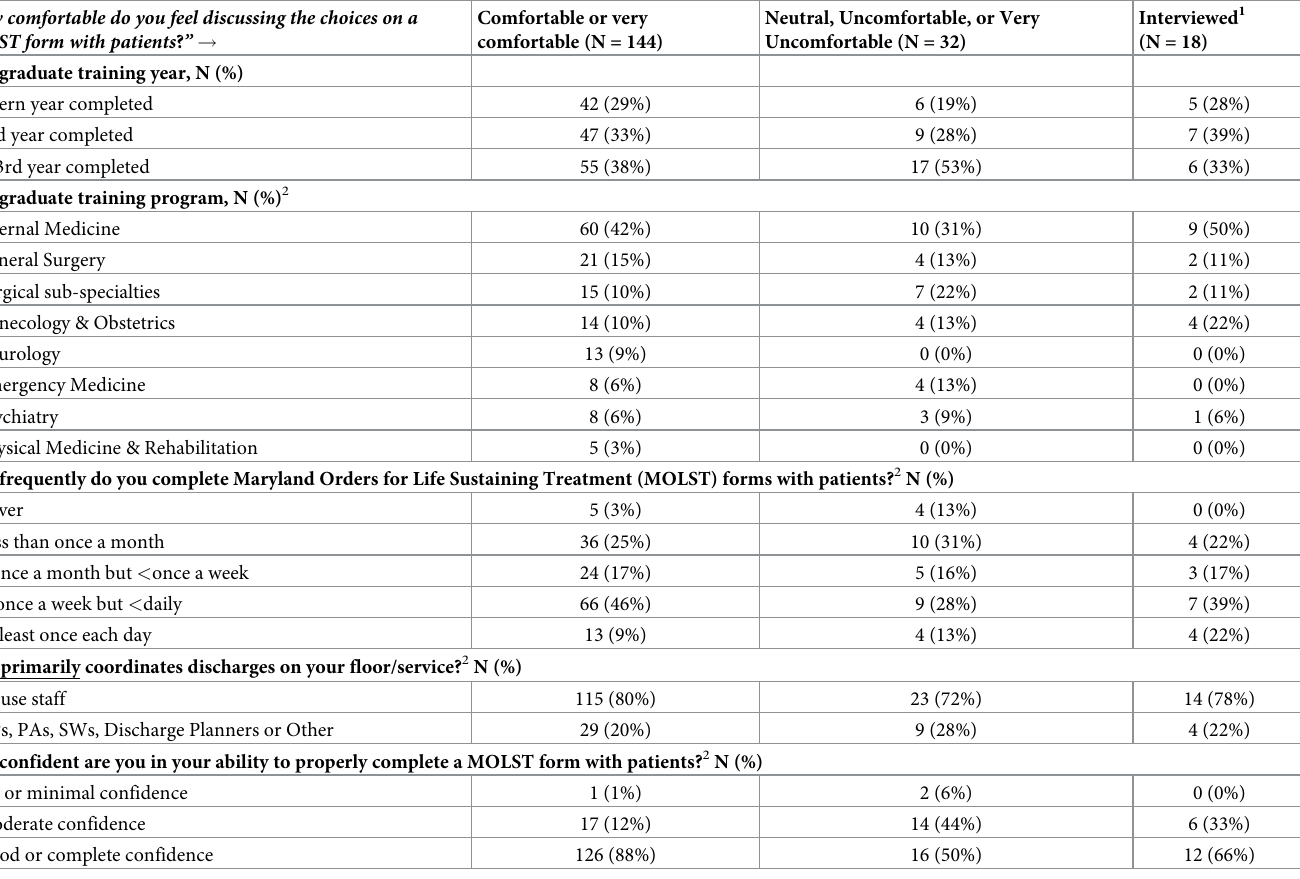
Table 1. Demographics of the 176 house staff with a MOLST knowledge score > 16 by self-reported comfort discussing the choices on a MOLST form with patients. “How comfortable do you feel discussing the choices on a MOLST form with patients ? ”